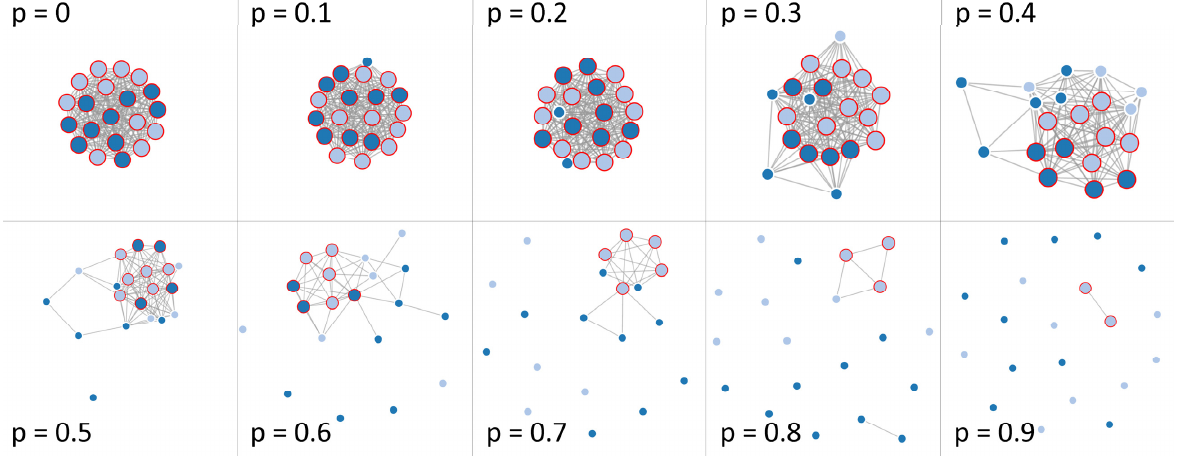
Figure 6. Example of the influence of parameter p